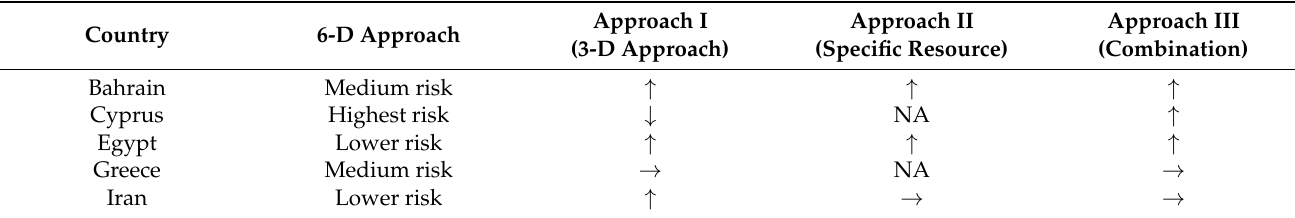
Table 7. Comparison of risk assessment results in West